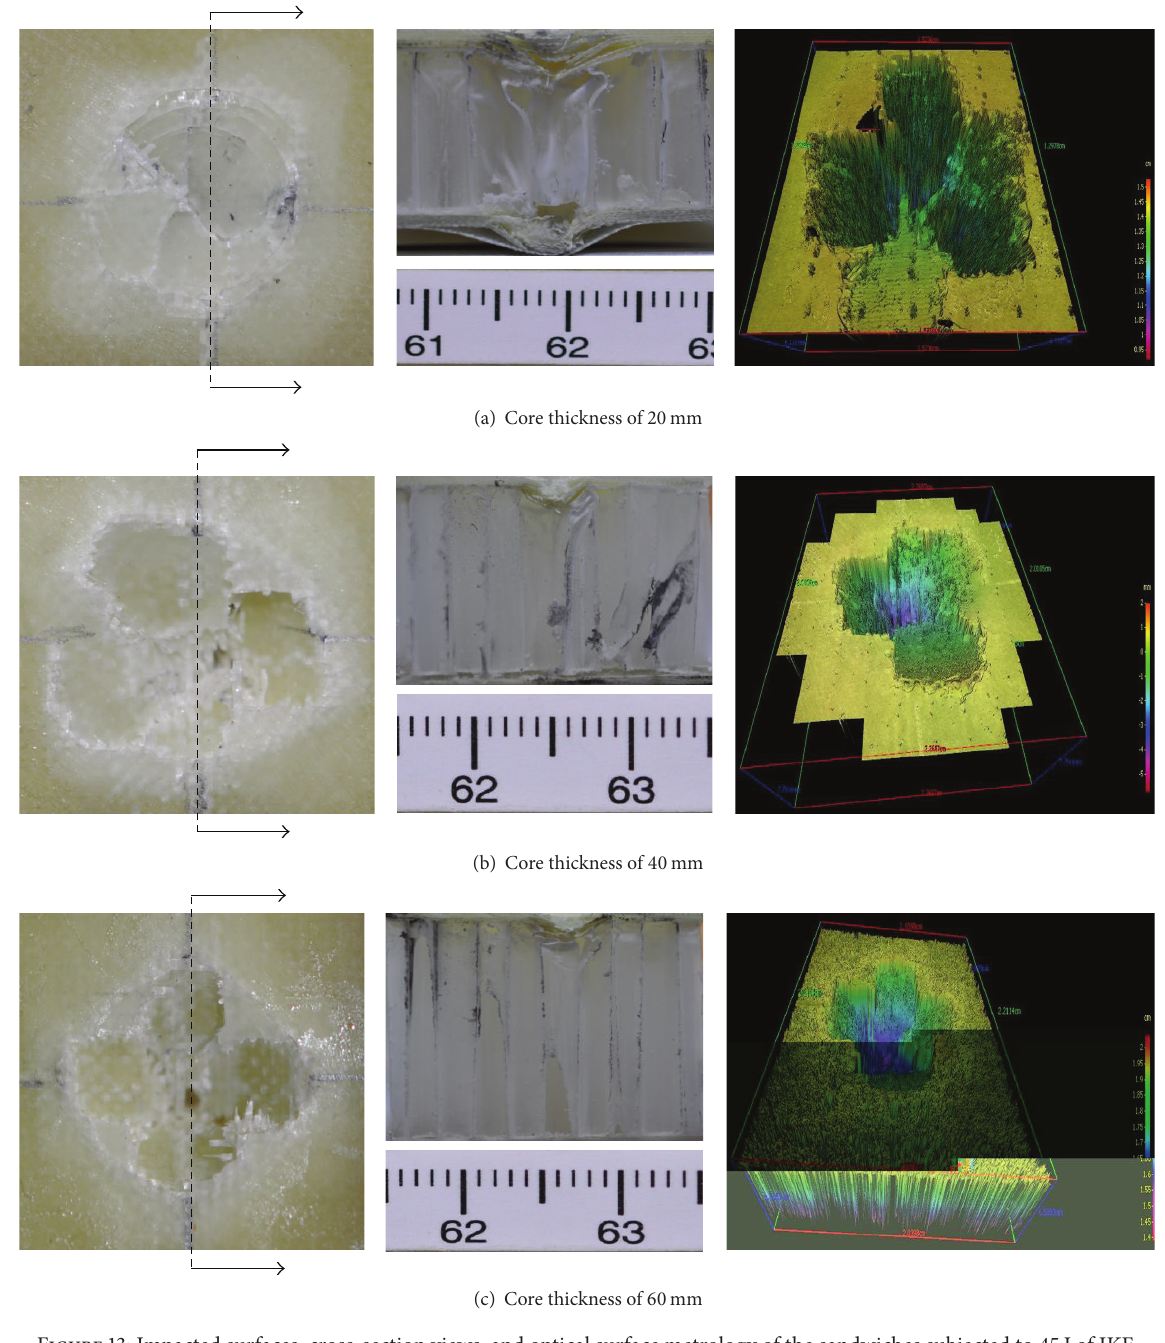
between the values was considerable small compared to the depth variations of the 60 mm